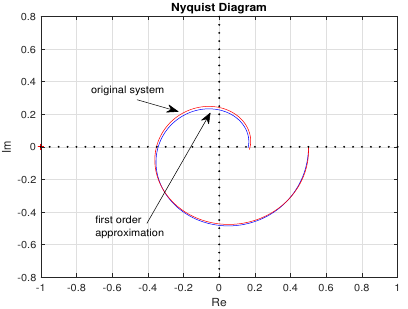
Figure 2. Nyquist diagrams of the original system and the first order approximation for ω [0 , 5] and h = 1. ∈